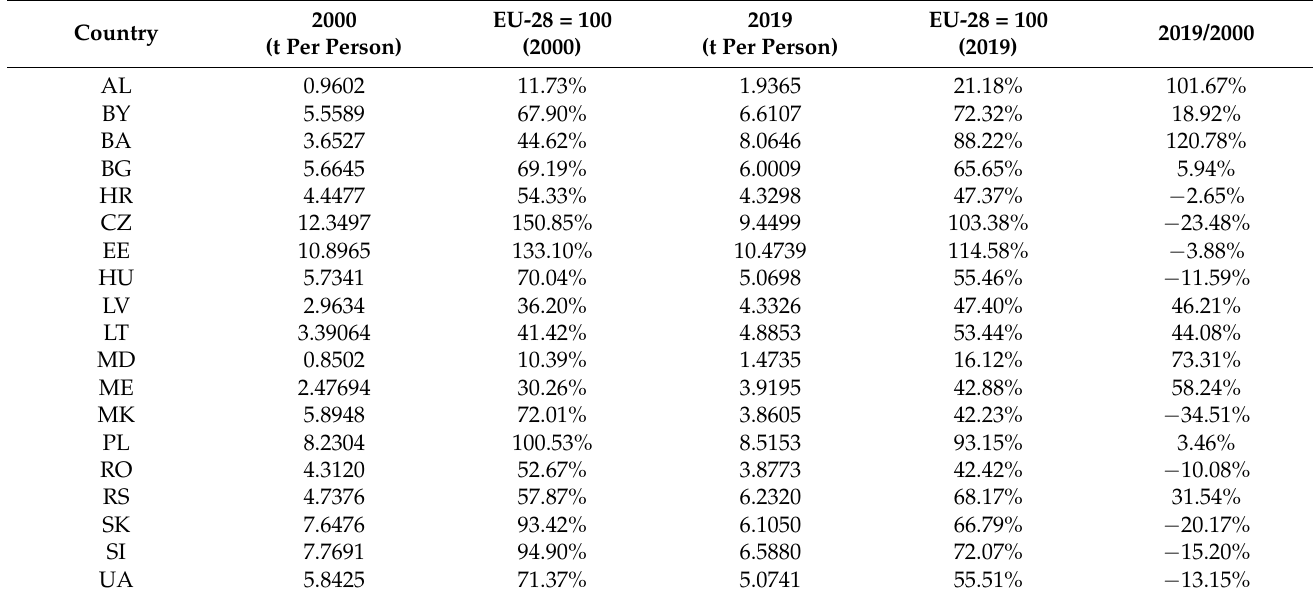
Table 2. Comparison of emissions of carbon dioxide in 2000 and 2019 (CO 2